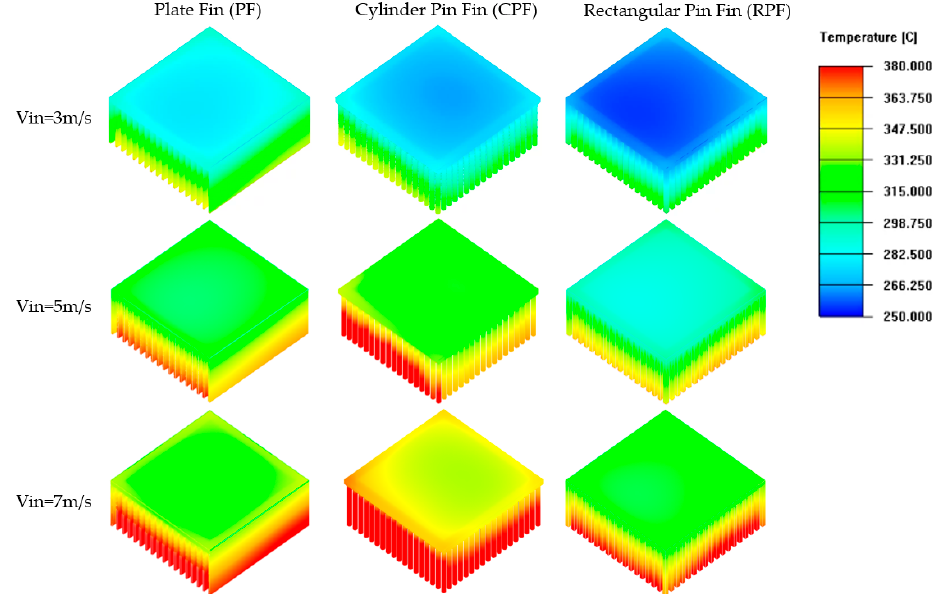
Figure 11. Temperature distributions across TEG module ( T in = 600 °C, V in = 1 m/s).